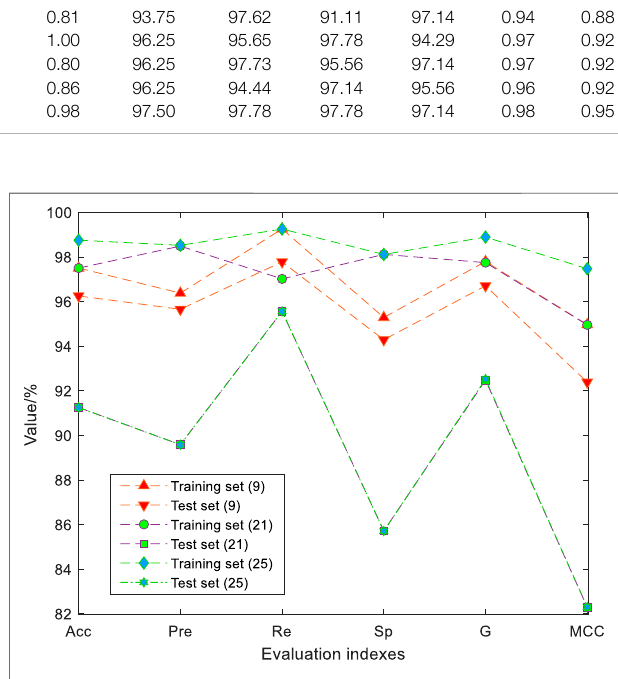
FIGURE 7 | Comparison of results after simplifying features. The values ofeachevaluationindexoftestset(9)arehigh.Theaccuracy,precision,recall, speci fi city, G-mean, and MCC of the test set were 96.25%, 95.65%, 97.78%, 94.29%, 0.97, and 0.92. The values of each evaluation index of test set (21) are low. The accuracy, precision, recall, speci fi city, G-mean, and MCC of the test set were 91.25%, 89.58%, 95.56%, 85.71%, 0.93, and